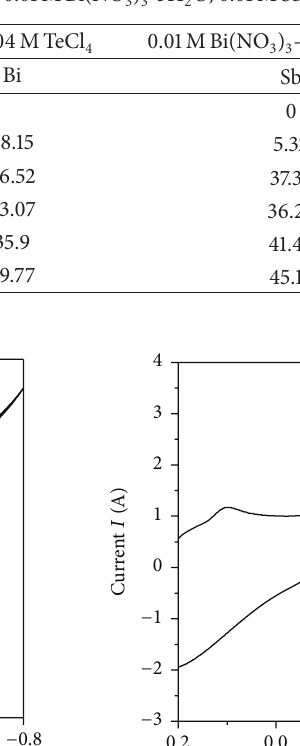
(b) 0.01 MBi(NO 4